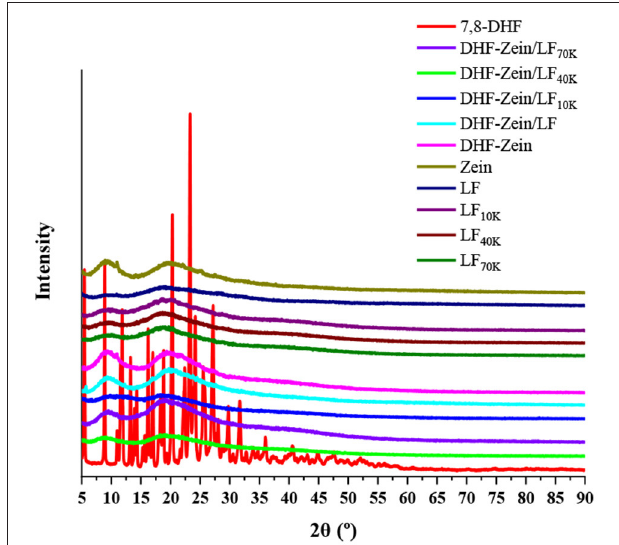
FIGURE 6 | X-ray diffraction (XRD) spectra of free 7,8-DHF, zein, LF, glycosylated LF DHF-zein, DHF-zein/LF, DHF-zein/LF 10K, DHF-zein/LF 40K, and DHF-zein/LF